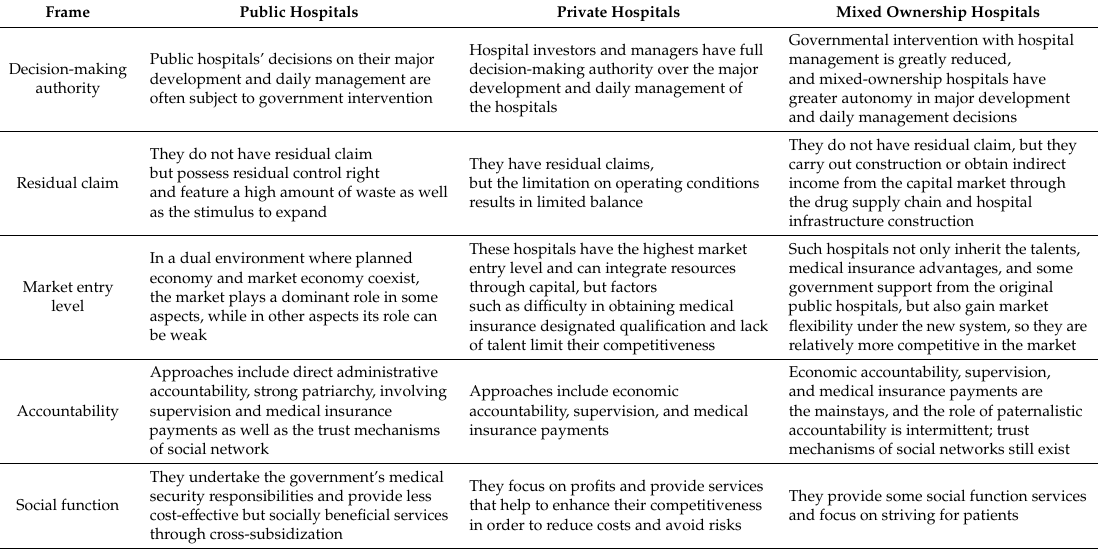
Table 2. Comparison of the organizational reform in hospitals of di ff erent